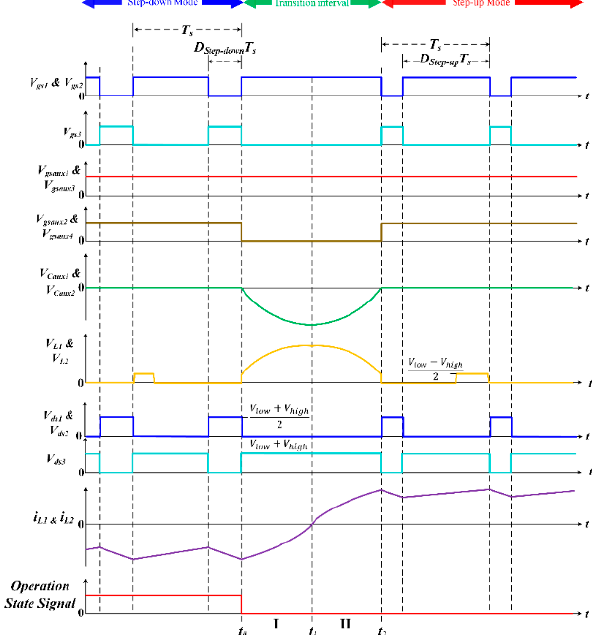
Figure 12. The process of the transition from the step-down mode to the step-up mode. Step-Down to Step-Up Mode I ( t 0 – t 1